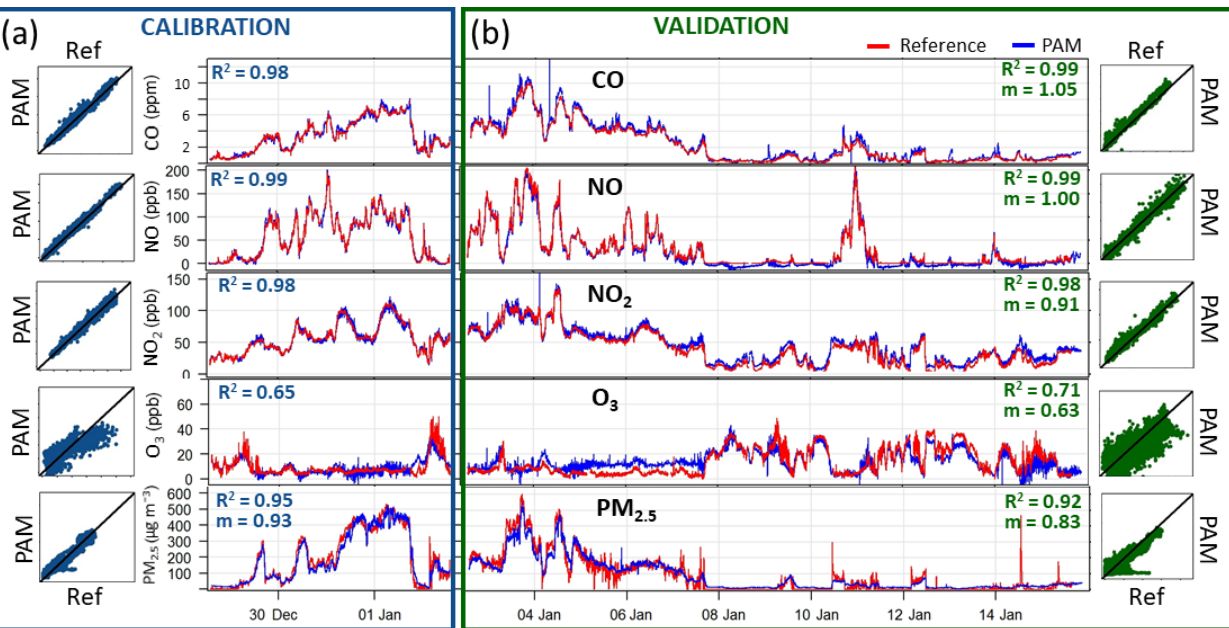
Figure 3. Outdoor co-location of one representative PAM with calibrated reference instruments in China (winter 2016/2017) at 1min time resolution demonstrating the calibration–validation methodology to evaluate the performance of the linear model. The first 5d (a) were used to calibrate the EC sensors. The remaining co-location data (14d, b ) were used to validate the extracted calibration parameters. The scatterplots on each side show the correlations between reference and PAM measurements with the 1:1 line in black R are shown on each side in the corresponding